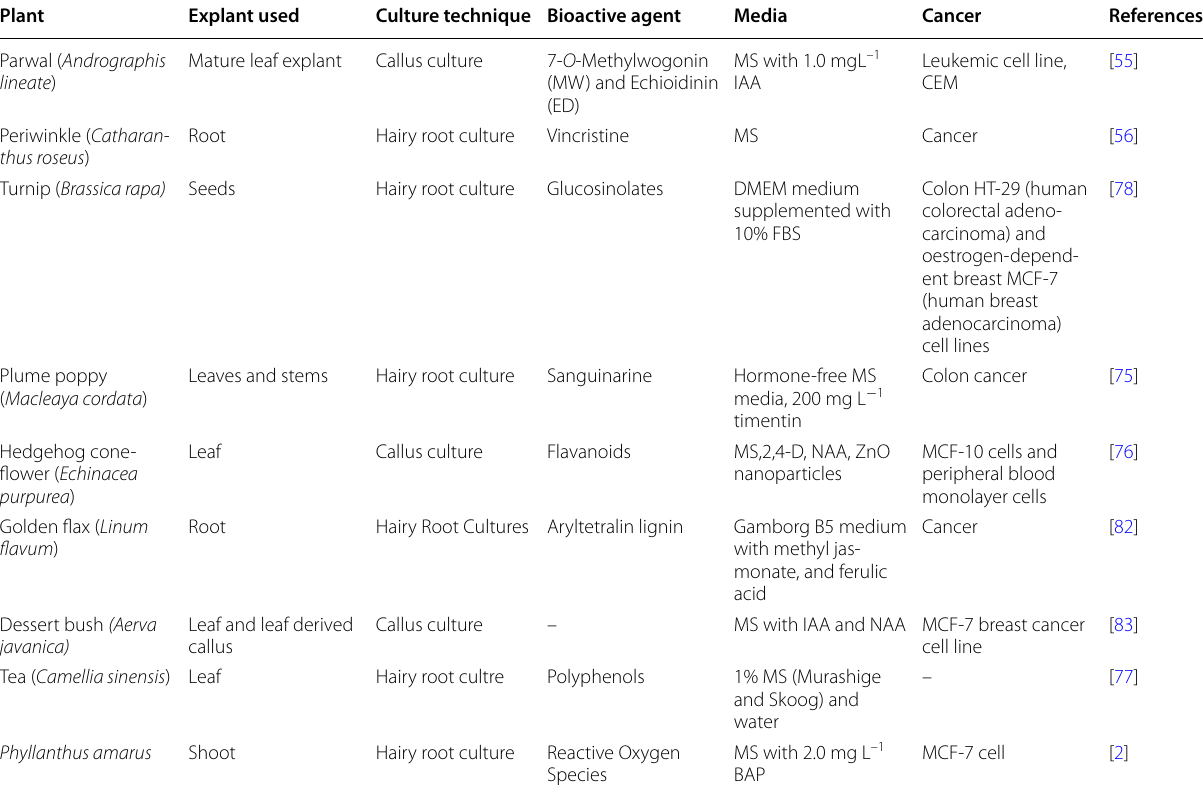
Table 3 Examples of therapeutic plants under plant tissue culture trials with anticancer activity